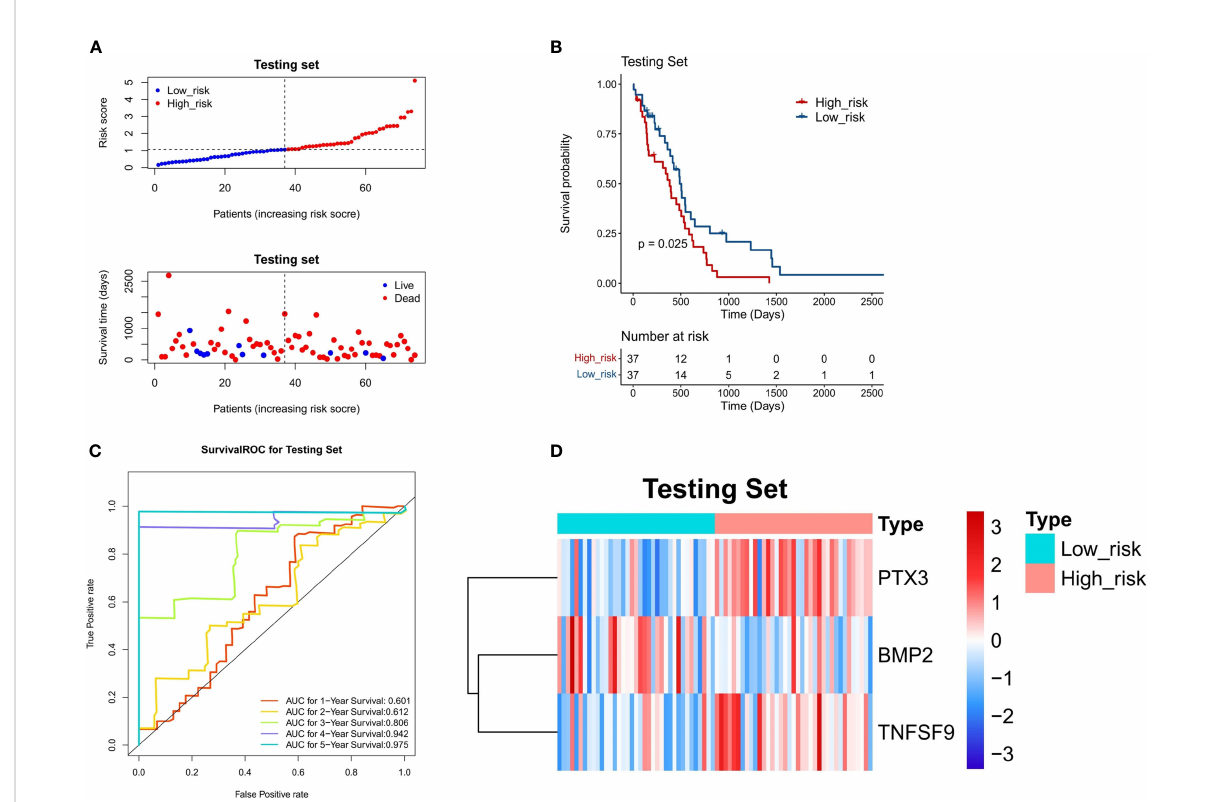
FIGURE 6 Validation of a 3-gene-based prognostic model using the test set (n = 74). (A) The prognostic curve and a scatter plot for the test set. (B) The Kaplan – Meier OS curves of the high- and low-risk groups for the test set ( P = 0.025). (C) ROC curve for the test set (AUC >0.6). (D) The heat map of the gene expression pro fi les of the three model genes in the test